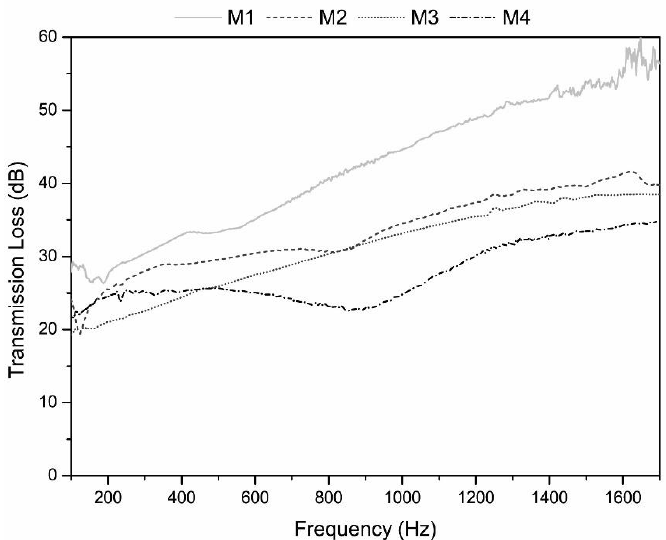
Figure 15. Transmission loss of the mineralized samples.